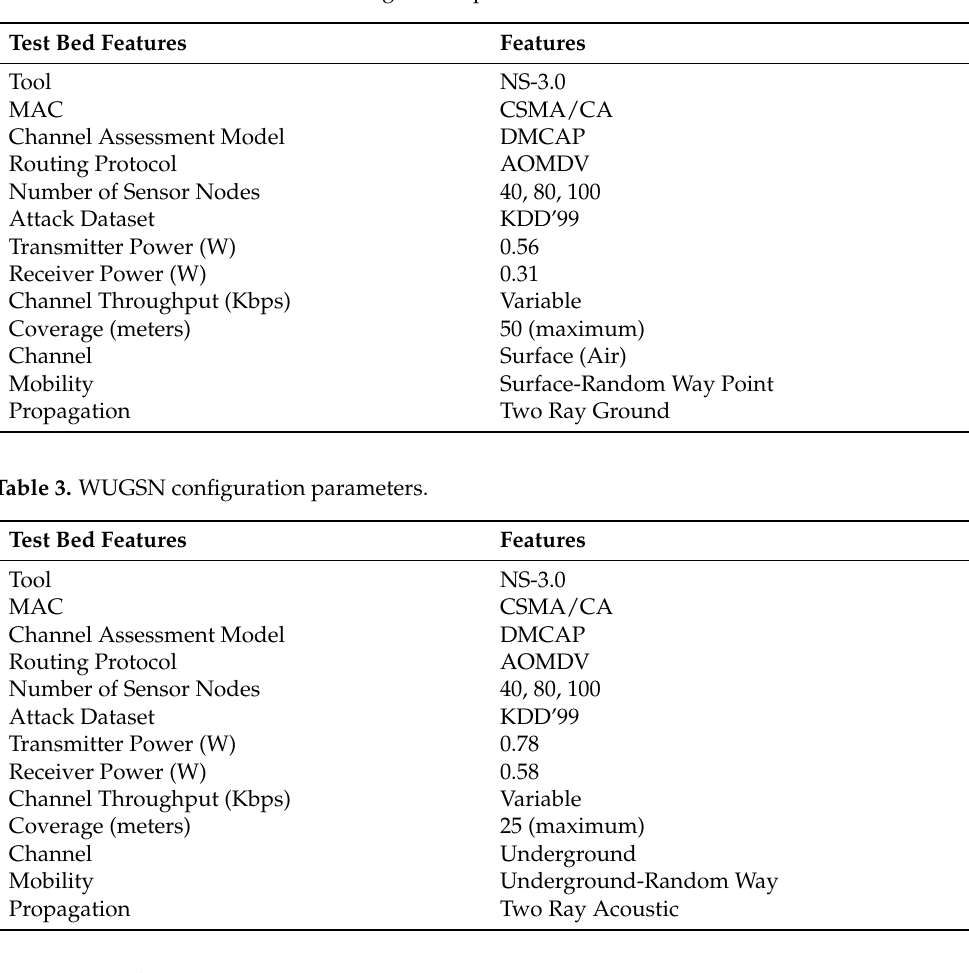
Table 2. WUGSN-surface channel configuration parameters.